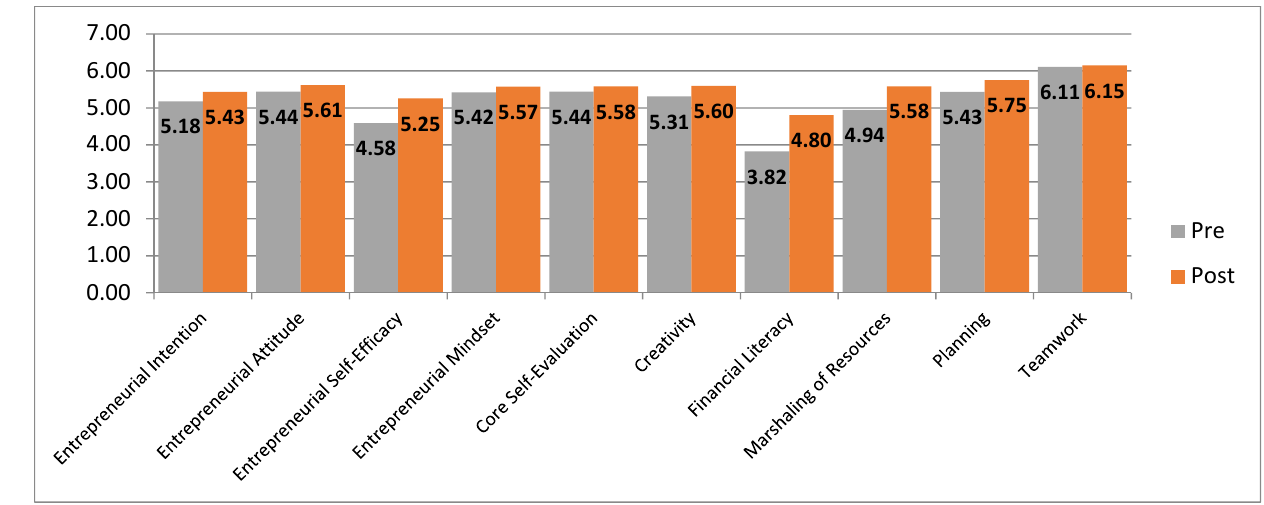
Figure 1. The average values of entrepreneurial characteristics, pre- and post-course.